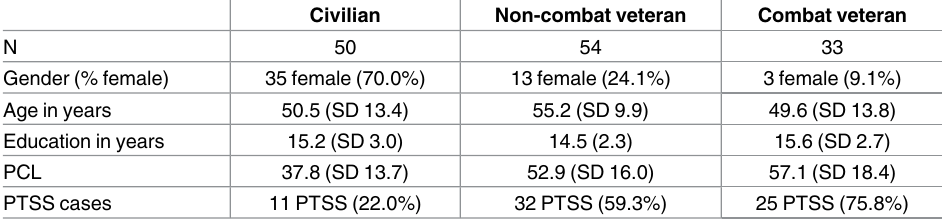
Table 1. Demographic information and PCL scores for the veteranand civilian